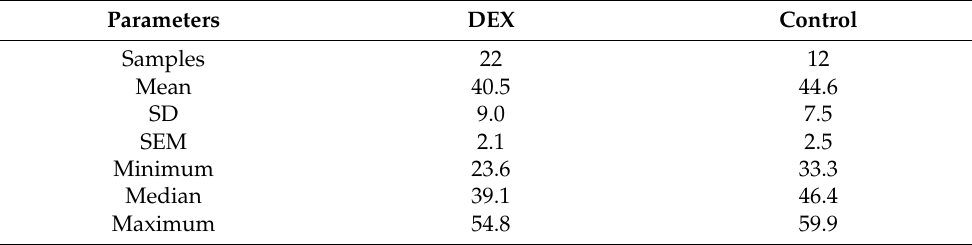
Table 2. Descriptive statistics of morphometry analysis performed on 34 samples (22 from DEX illicit treated animals, 12 from controls). Data of the only sample from an animal treated with therapeutic dose of dexamethasone are not